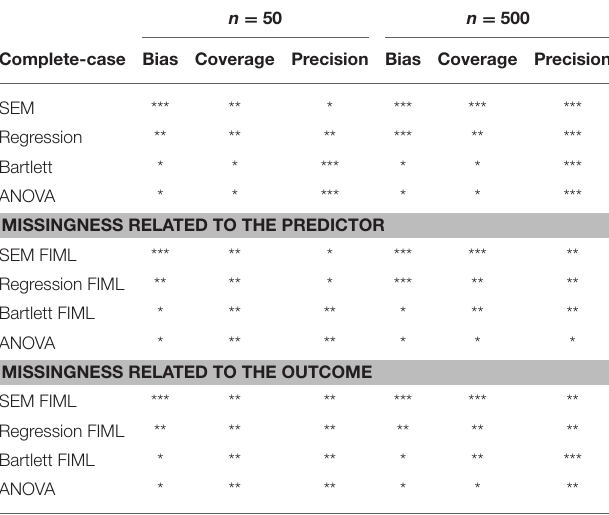
TABLE 3 | Comparison of the methods: SRM as